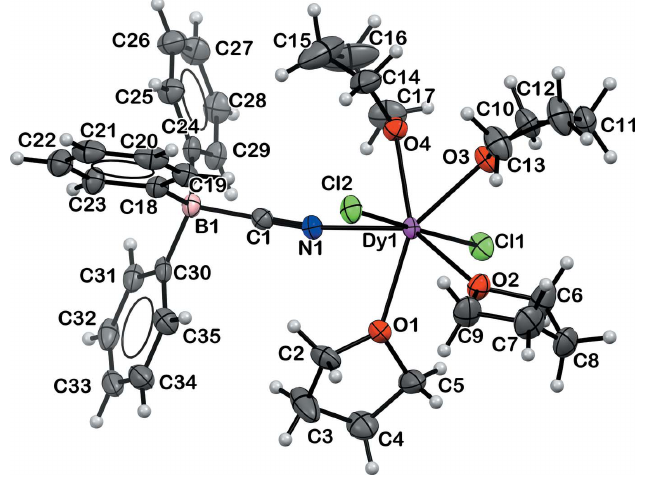
Figure 2 Displacement ellipsoid plot of 2 , [NEt 4 ][B 3 ( (cid:4) -O) 3 (C 6 H 5 ) 4 ], drawn at the 30% probability level. The disorder in the [NEt 4 ] + cation is omitted for clarity.